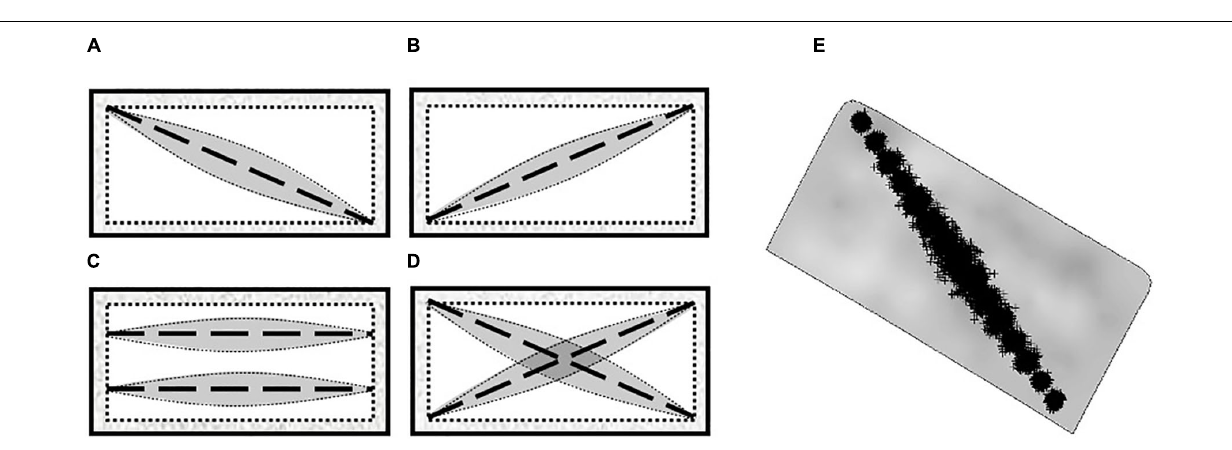
FIGURE 2 | Different types of simulated trajectories: (A,B) single-diagonal, (C) double-parallel transect, and (D) double-diagonal ( X -shape), and (E) example of 500 simulated single diagonals with 15 sampling points, J